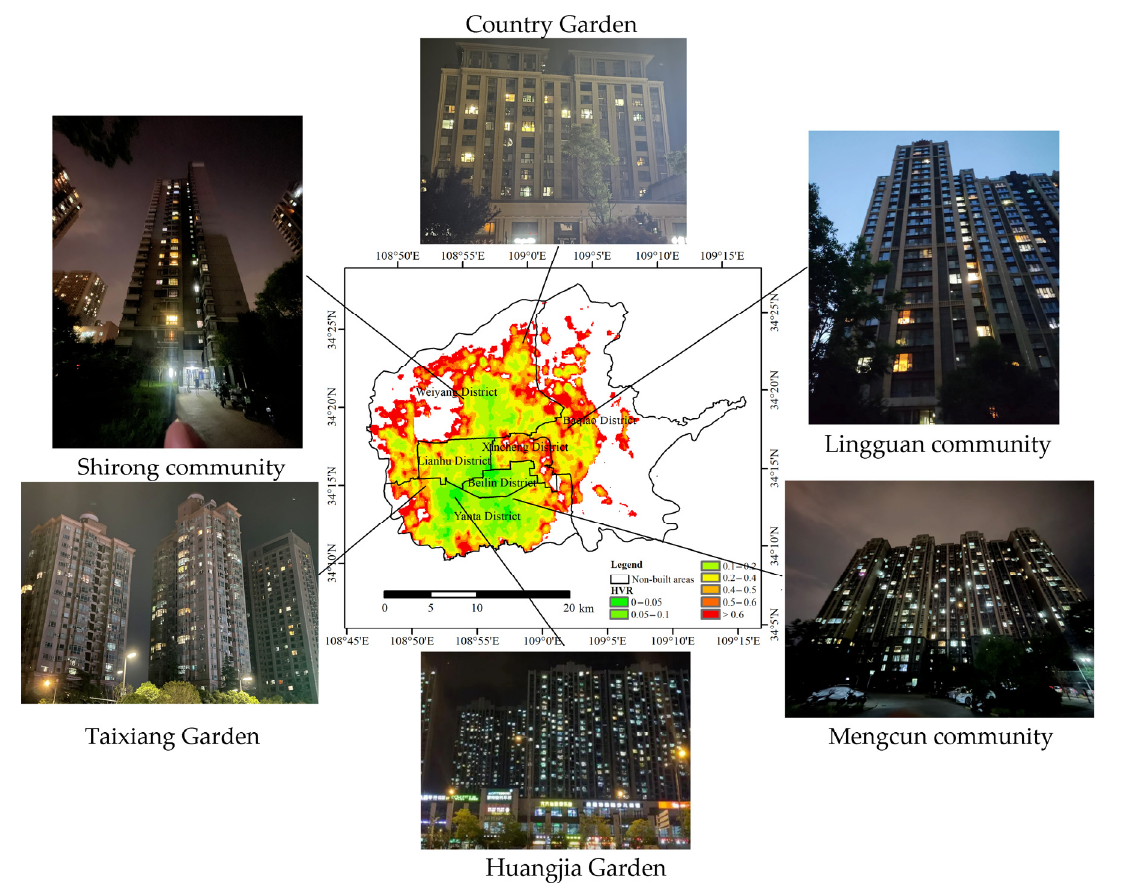
Figure 10. Results validation in the community.